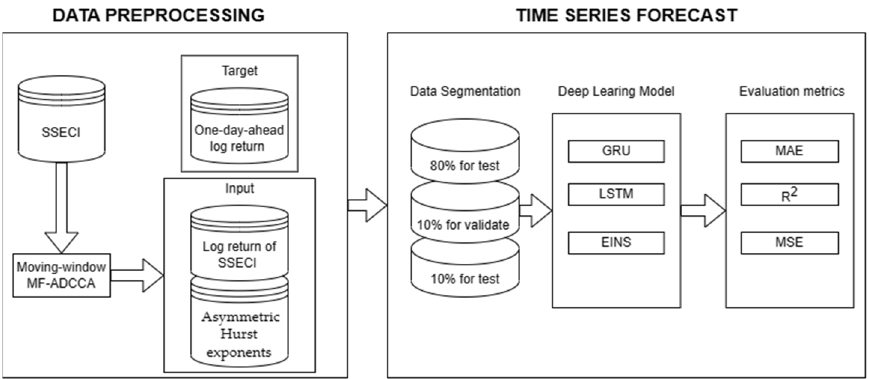
Figure 7. Flowchart of time series prediction implementation.